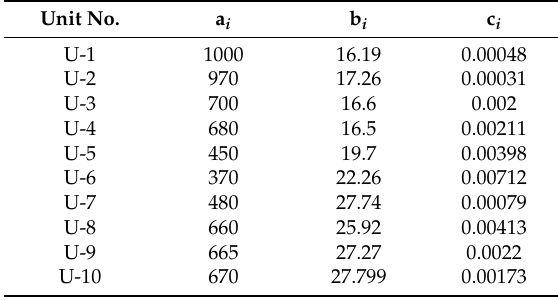
Table 1. Load curve data for the 10 unit IEEE 39 bus